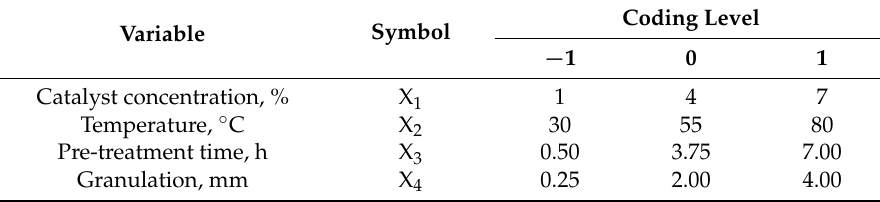
Table 4. Input variables for the four-factorial Box-Behnken design.